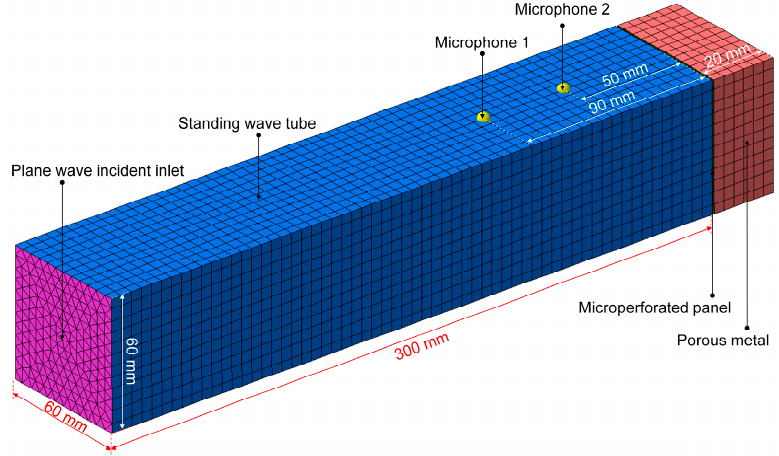
Figure 10. Finite element simulation model of the composite sound-absorbing structure.